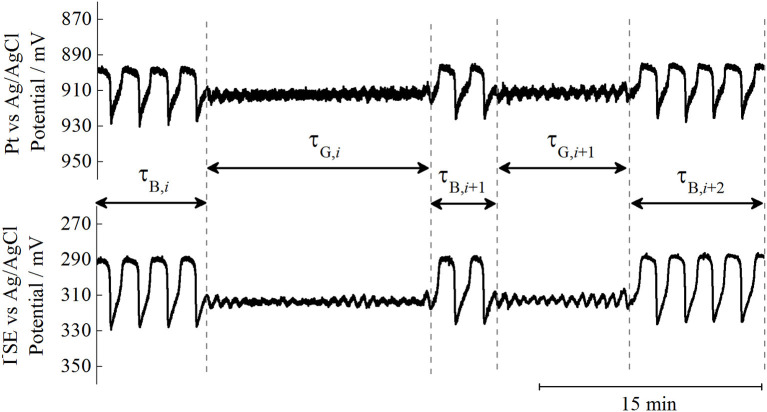
Potentiometric traces, recorded by Pt (upper) and I−SE (lower) electrodes vs. referent Ag/AgCl, over identical time intervals in order to illustrate different noise levels. Displayed oscillograms were obtained for the following experimental conditions: [KIO3]0 = 0.035 M, [H2SO4]0 = 0.077 M, [H2O2]0 = 0.240 M, T = 63.0oC, σ = 900 rpm and j0 = 0.068 min−1.